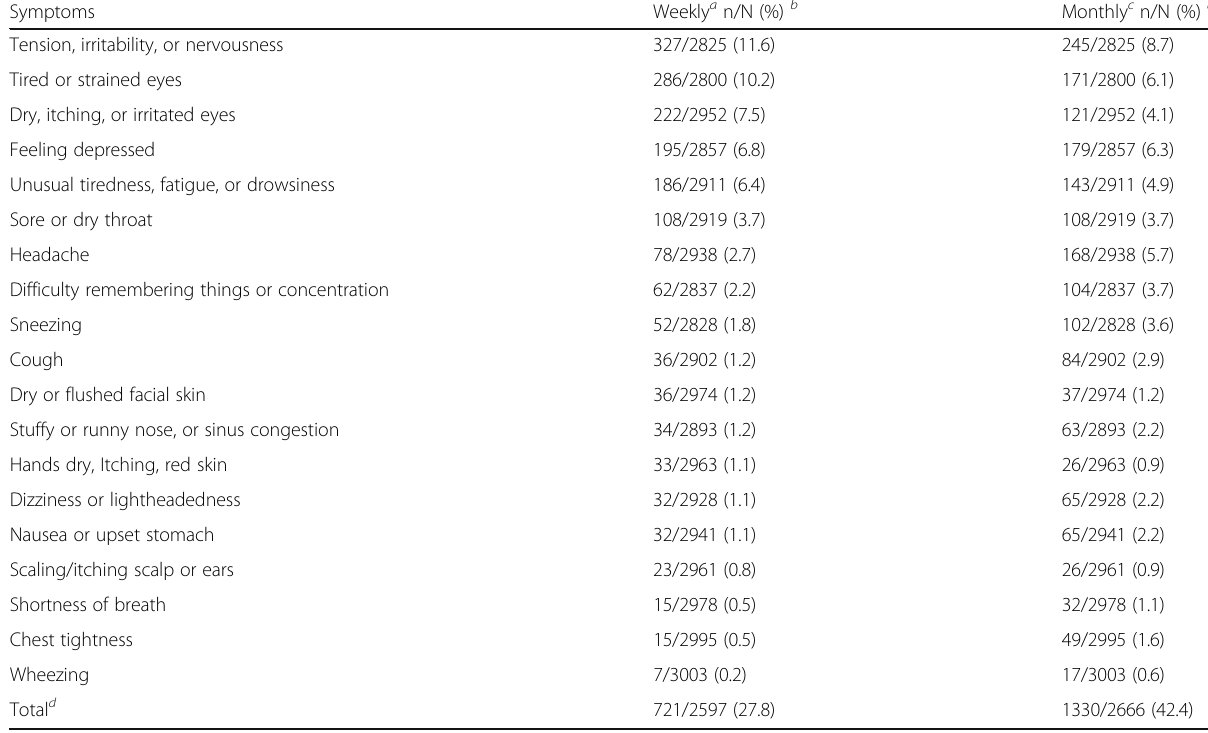
Table 2 Prevalence of health symptoms related to work environments ( N = 3024)